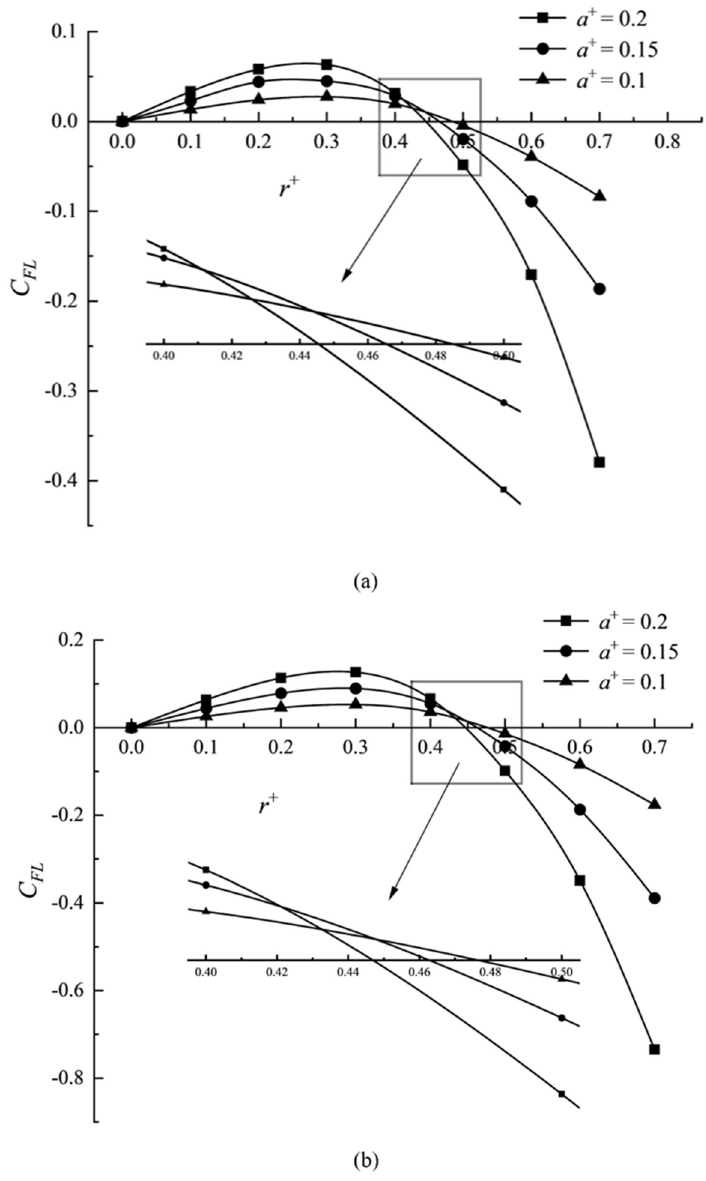
Fig 9. Lift distribution of elliptical particles and its corresponding circular particles under different relative size. (a) elliptical particles and (b) circular particles.